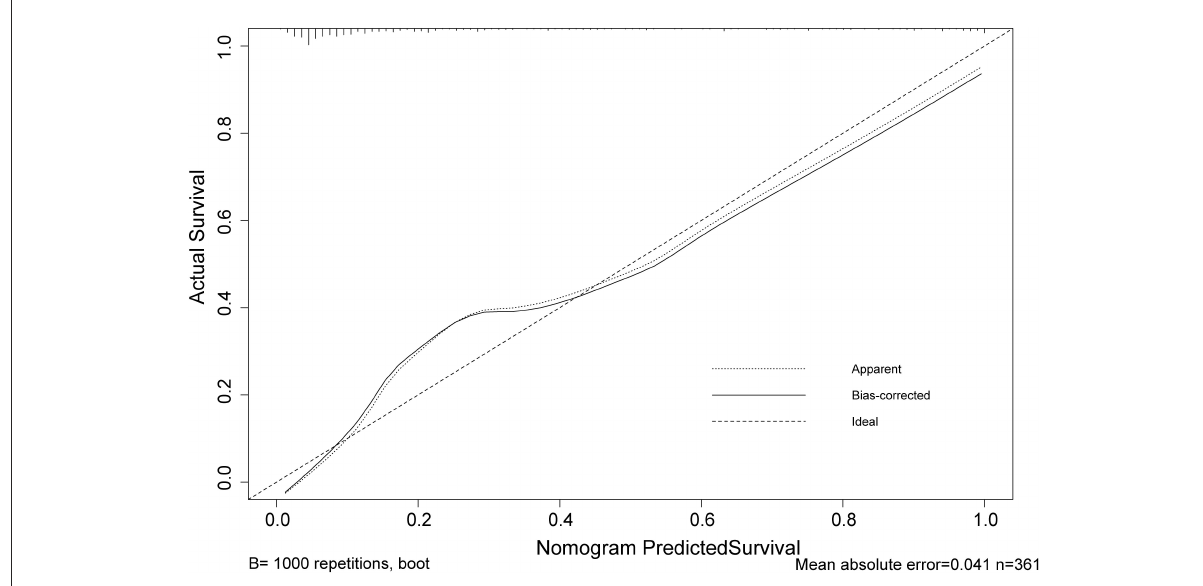
FIGURE4 Calibration curve of the poor neurological outcomes recovery nomogram prediction in the cohort. Predicted poor neurological outcomes recovery risk is represented by the x-axis. The y-axis represents the actual diagnosed poor neurological outcomes recovery. Ideal model predictions are represented by the diagonal dotted line. The solid line represents the predictive performance of our nomogram, and a closer fit to the diagonal dotted line indicates a better